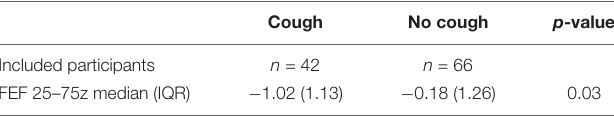
TABLE 2 | Results for normalized FEF 25–75 (z-score) measured at T2 for adults that reported symptoms during acute SARS-CoV-2 infection. Cough No cough p -value